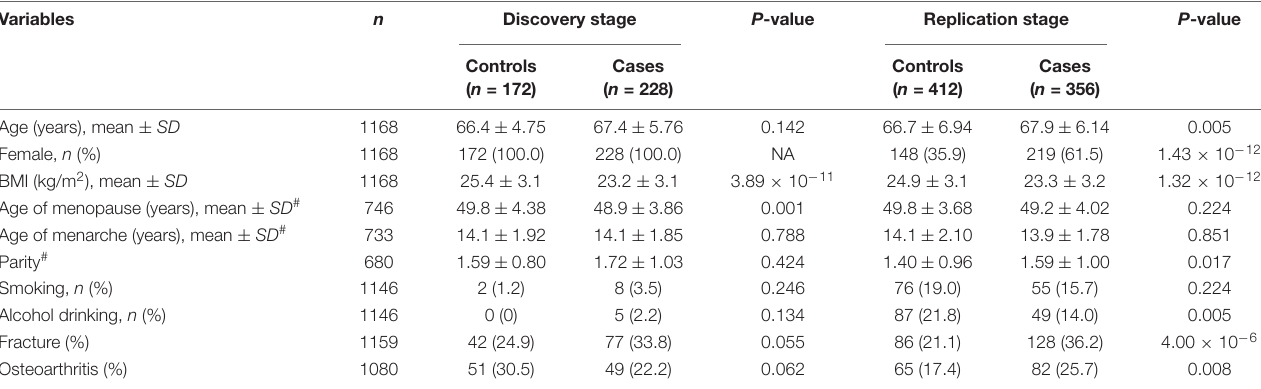
TABLE 1 | Characteristics of included subjects for genotyping in the